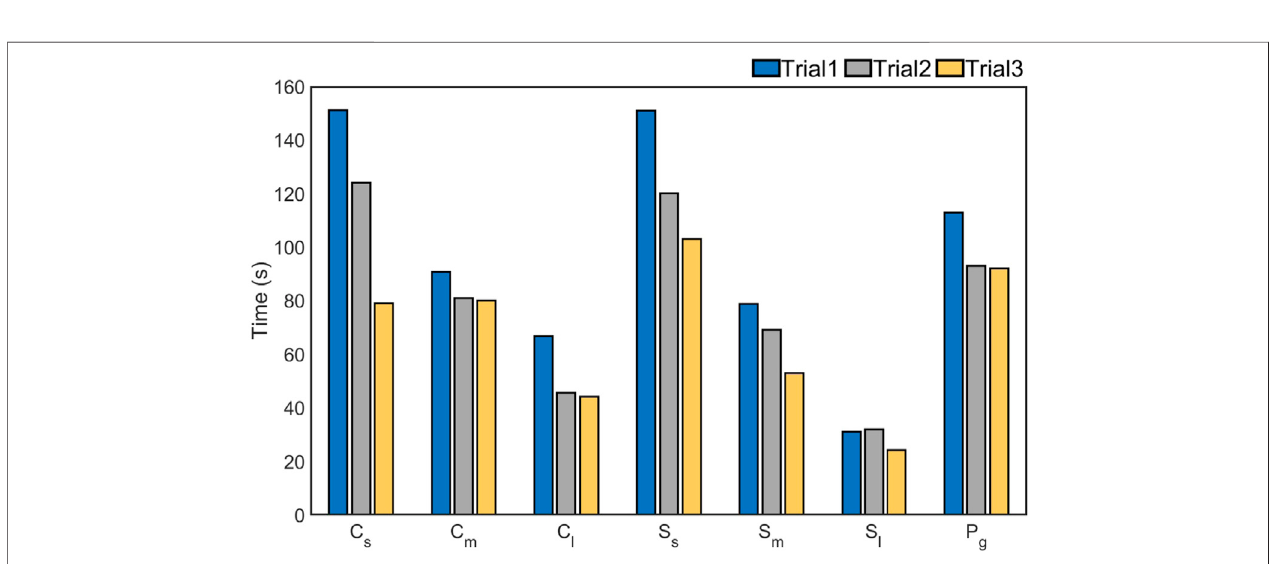
Frontiers in Robotics and AI |